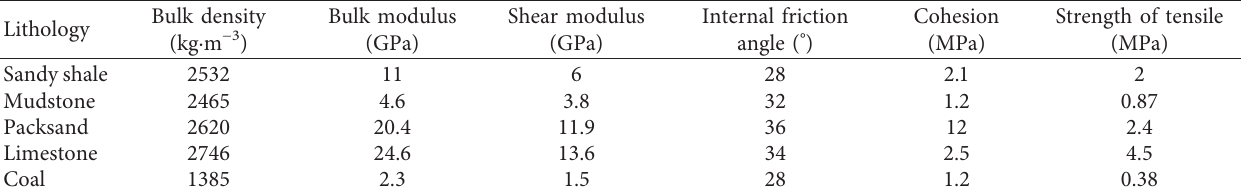
Table 1: Physical and mechanical parameters of each rock stratum.